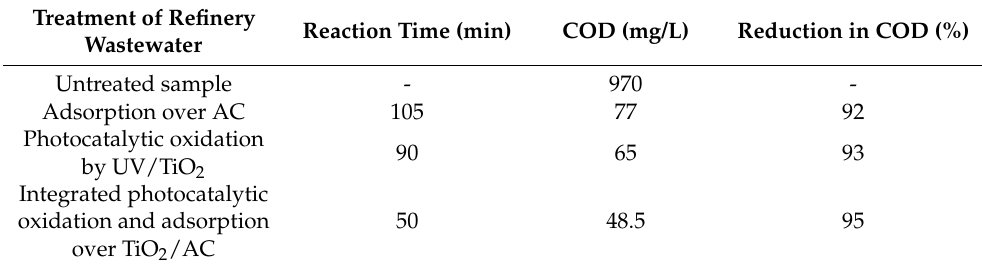
Table 8. Decrease in COD of refinery wastewater by various treatment